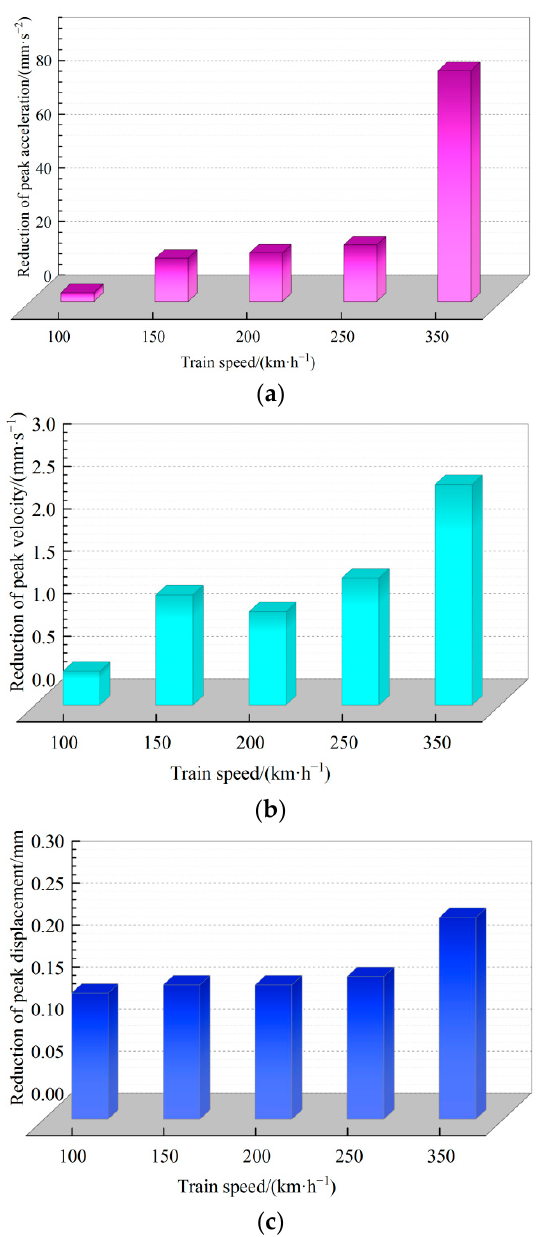
Figure 14. Reduction in dynamic response indexes from tunnel roof to tunnel floor. ( a ) Peak vibration acceleration. ( b ) Peak vibration velocity. ( c ) Peak vibration displacement.